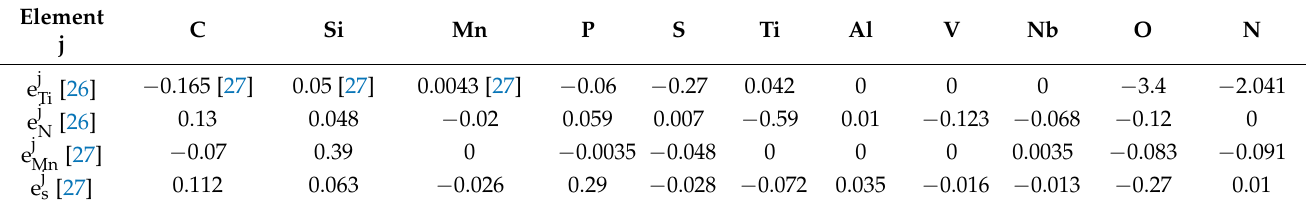
Table 4. Interaction coefficients of elements to Ti, N, Mn and S elements at 1600 °C. Element j